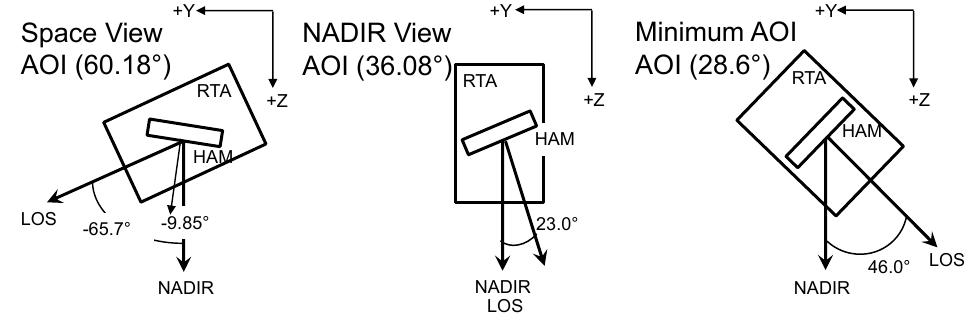
Figure 1. Example of the Rotating Telescope Assembly (RTA) and Half Angle Mirror (HAM) Orientations at three different scan angles. The left most diagram corresponds to the Space View (SV) scan angle, the middle is the NADIR scan angle and the right most is the scan angle where the HAM Angle of Incidence (AOI) is at a minimum.